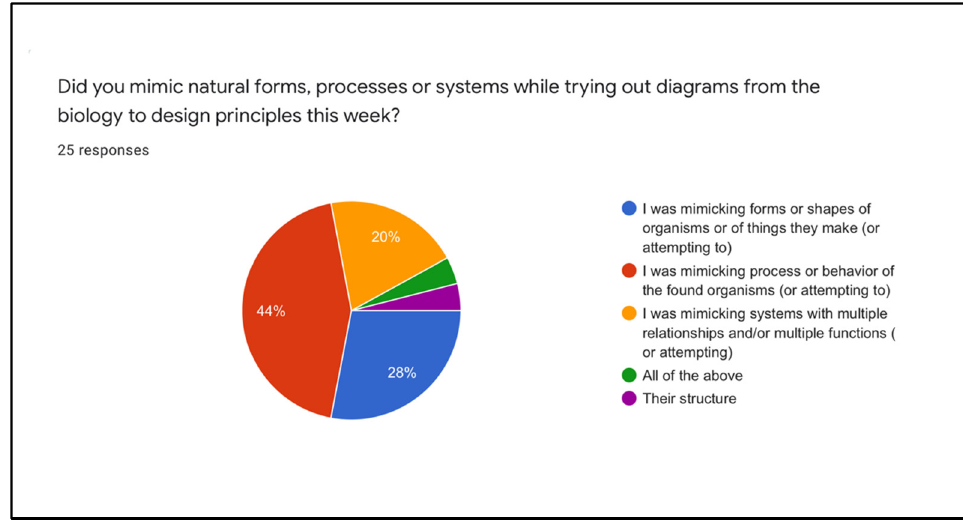
Figure 6. Student responses to analogy type. (small section pie 4% each)